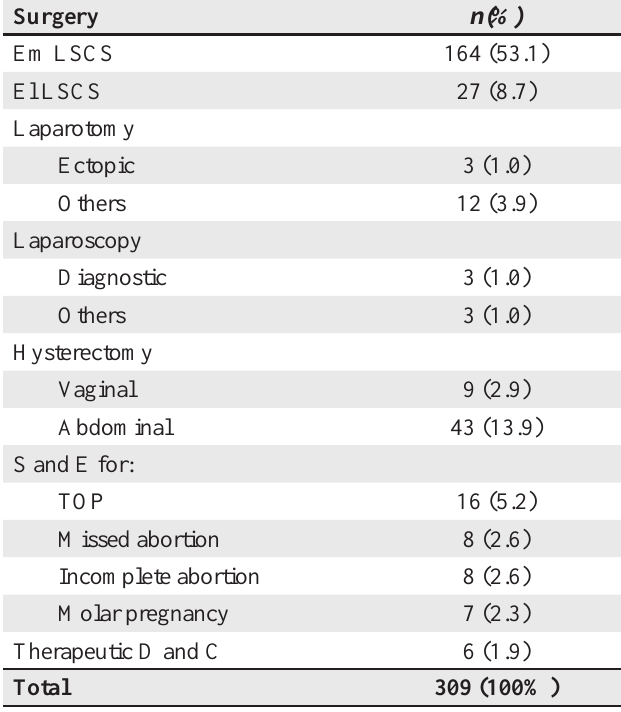
Table 1 : List of surgeries performed during the study period